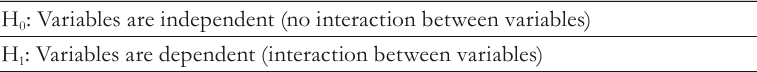
Tab. 6 - Q2a Chi-squared Test and p-value. Source: authors Pearson’s Chi-squared test with simulated p-value (based on 5000 replicates) H : Variables are independent (no interaction between variables) 0 H : Variables are dependent (interaction between 1